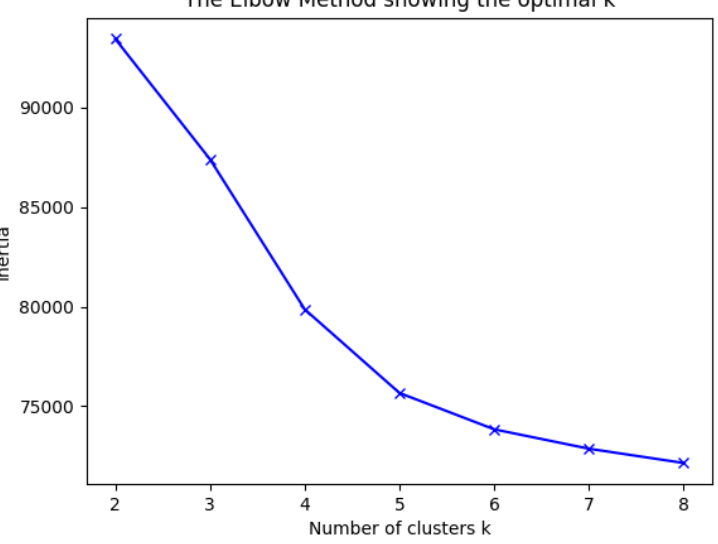
Figure 1. Elbow method plot on sports bets’ data using the time series k -means algorithm.